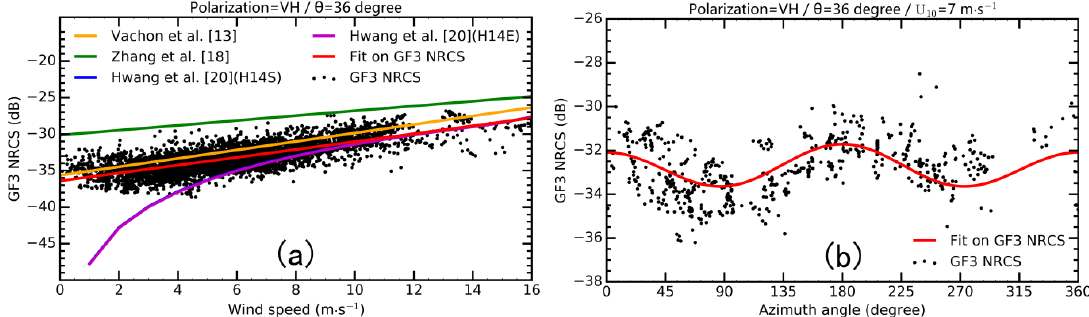
Figure 11. Same as Figure 5, but for VH polarization. The GF-3 NRCS data are fitted and compared to four proposed